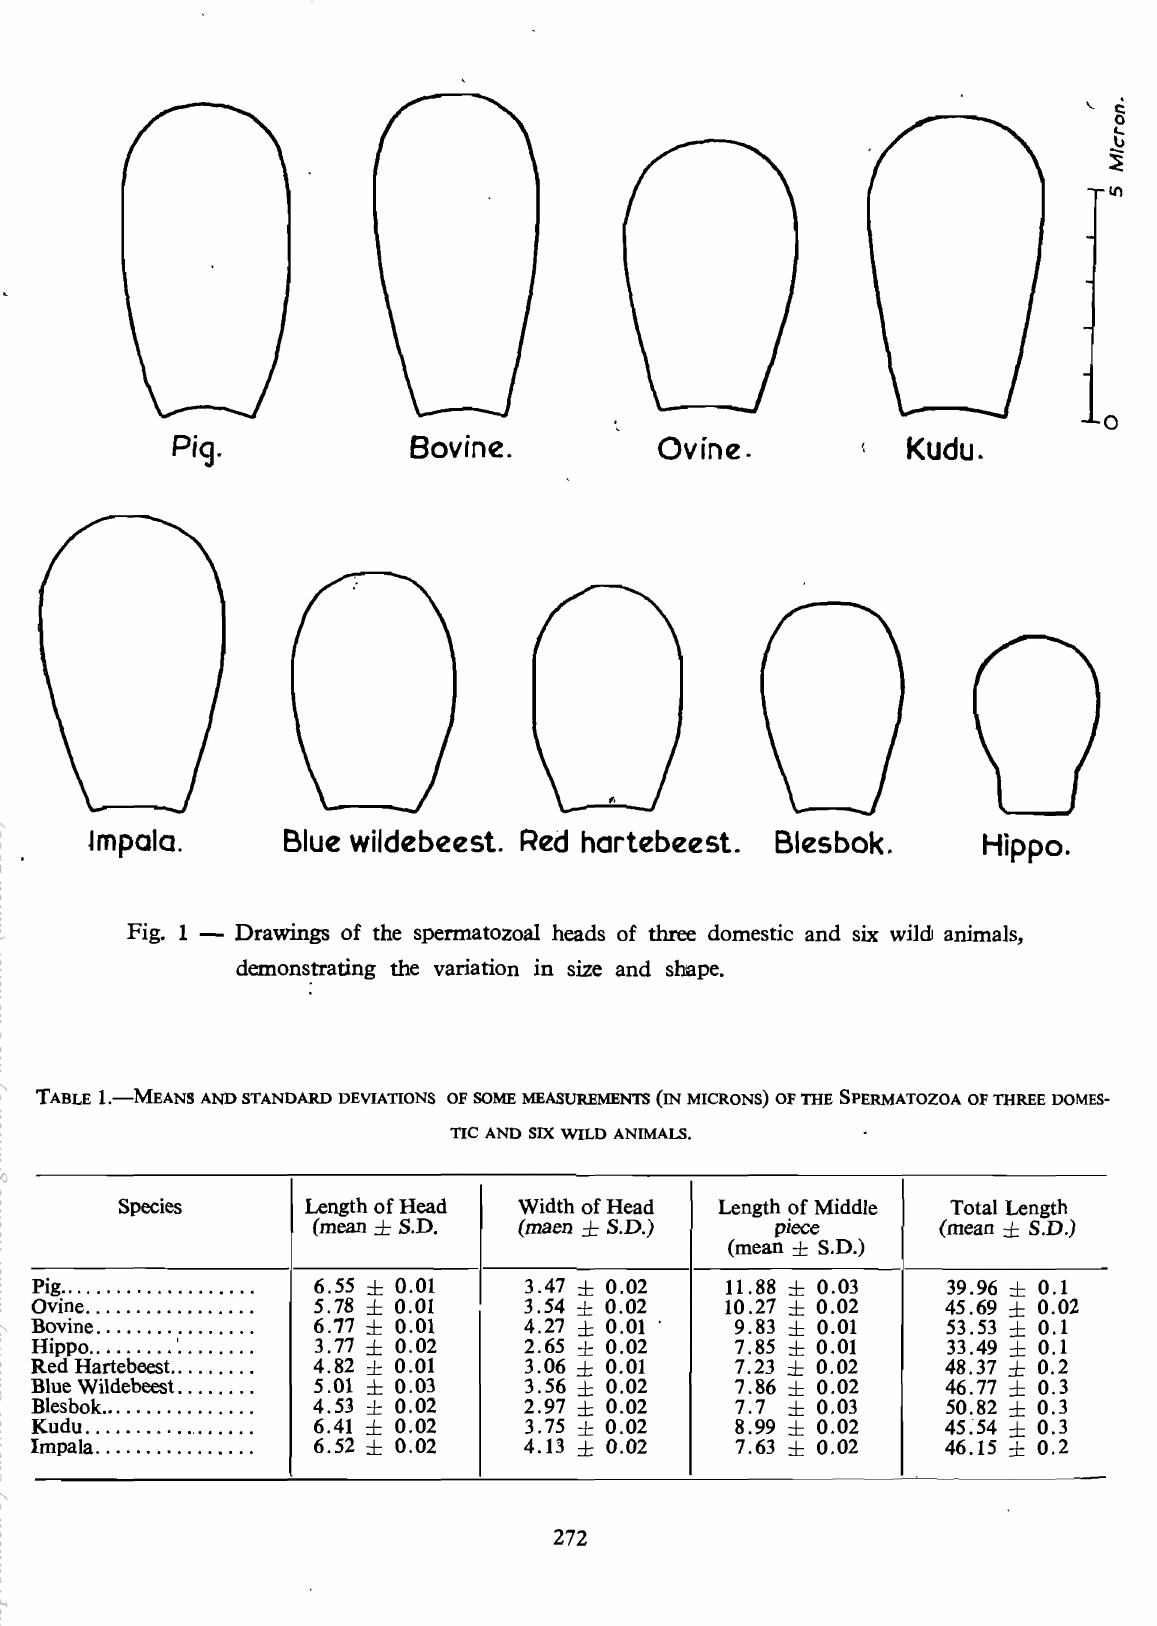
Pig. Bovine. Ovine.